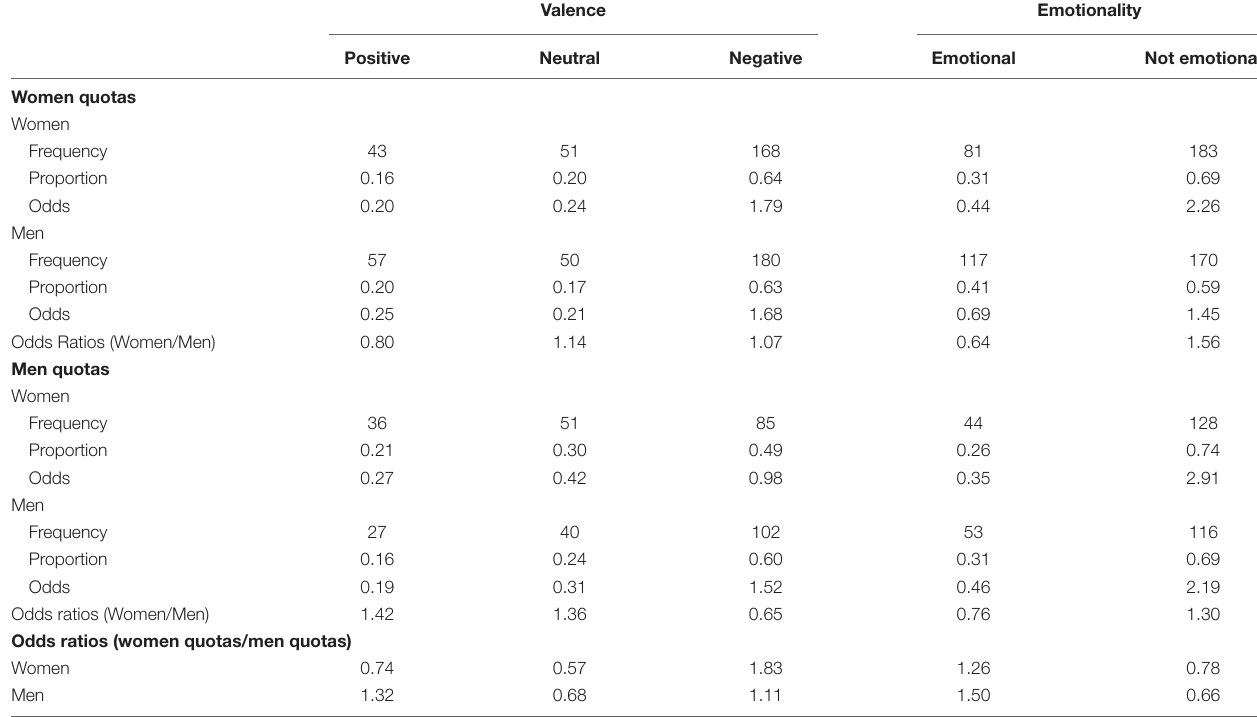
TABLE 2 | Frequencies, proportions, odds, and odds ratios of the valence and the emotionality of the free associations by quota and gender. Valence Emotionality Positive Neutral Negative Emotional Not emotional